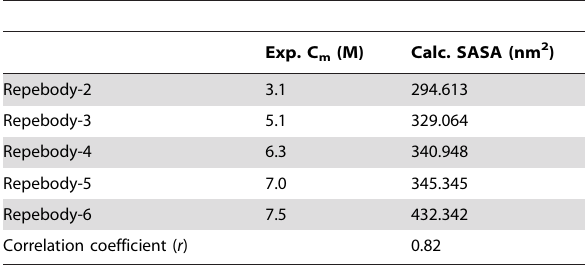
Table 4. Correlation between concentration of urea C m and